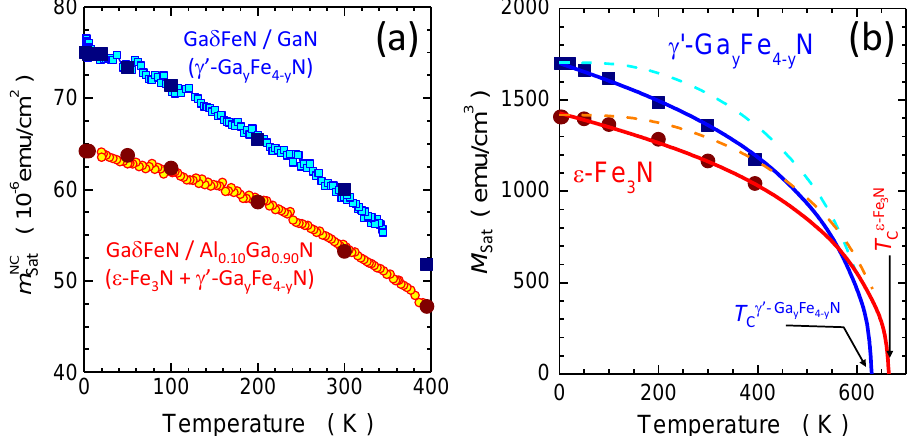
( T ) in the studied Ga δ FeN layers NC NC ( 0 ) and T C NC